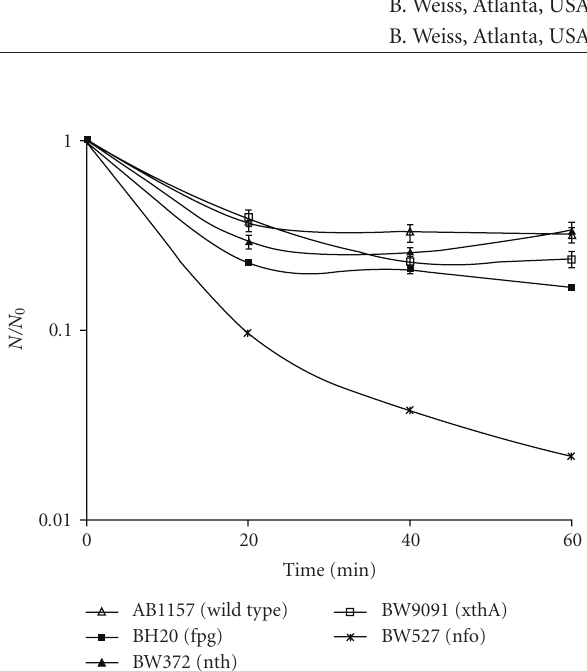
Figure 1: Survival fraction of E. coli AB1157, BH20, BW372, BW9091, and BW527 treated with SnCl 2 . Mid-log phase cells suspended in 0.9% NaCl were treated with 25 μ g/mL SnCl 2 for di ff erent incubation times and the specific survival fraction. Survival fraction values are means ± standard deviations of the three isolated